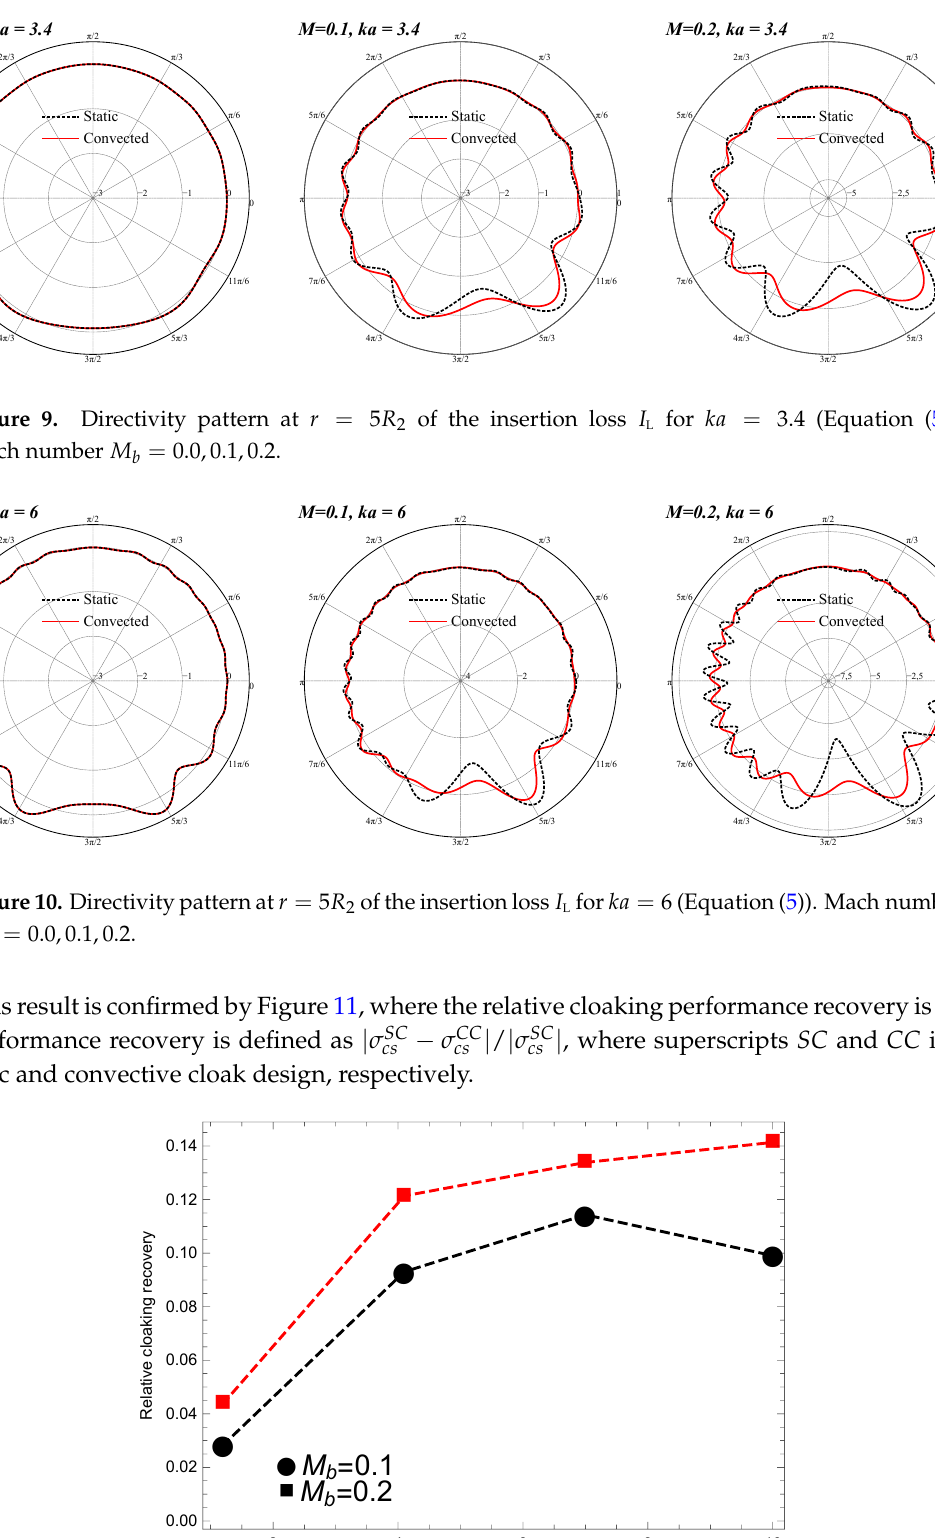
Figure 11. Relative cloaking recovery performance of the convective cloak, | σ SC cs − σ CC cs | / | σ SC cs | . Black dots M = 0.1; red squares M b =